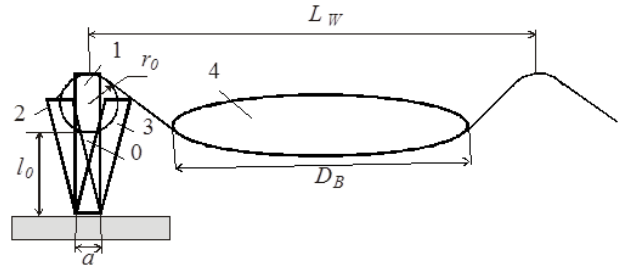
Figure 3. Selecting PMC dimensions